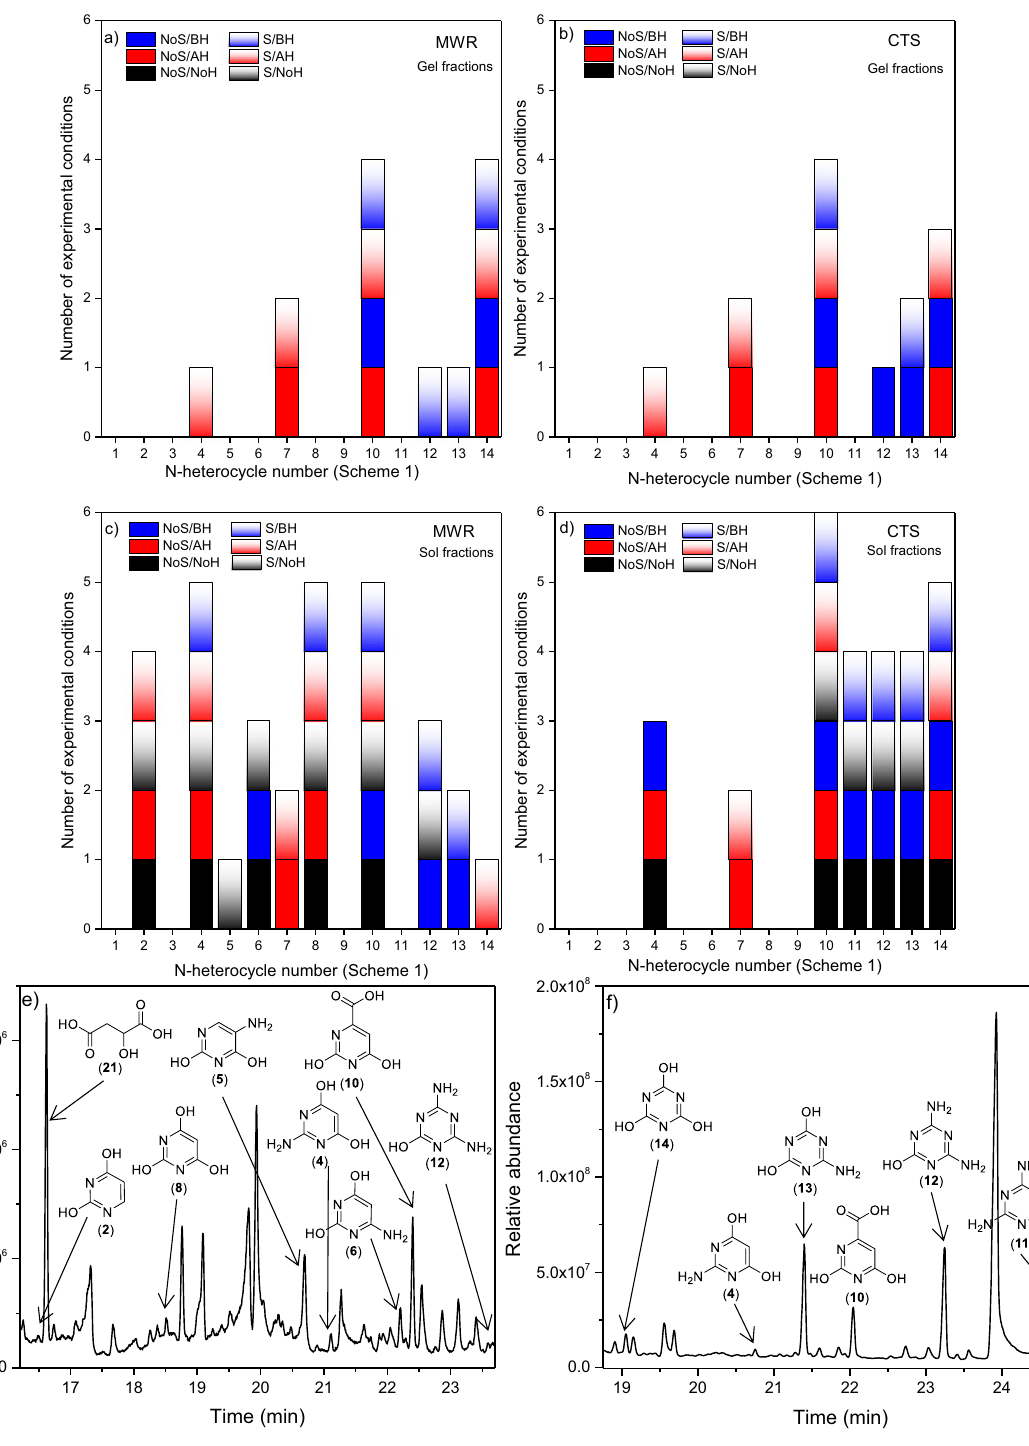
Figure 5. Summary of the qualitative GC–MS analysis for pyrimidines and triazines from alkaline hydrothermal cyanide polymerization under plausible subaerial conditions (MWR, 180 °C) and aerial conditions (CTS, 80 °C) of ( a ) and ( b ) gel fractions (insoluble polymers) and ( c ) and ( d ) sol fractions (soluble fractions). The numbers on the abscissa axis correspond to the enumeration of the N-heterocycles shown in Fig. 1. NoS = static experiments without stirring; S = stirring experiments. NoH = nonhydrolysed samples; AH = acid hydrolysed samples; BH = basic hydrolysed samples. Representative chromatograms of these types of analysis: ( e ) nonhydrolysed sol fraction from the assisted MW polymerization of cyanide in a stirring experiment; and ( f ) nonhydrolysed sol fraction from the cyanide polymerization under plausible aerial conditions in a static experiment. The scale of retention time in both chromatograms is different for better visualization of the